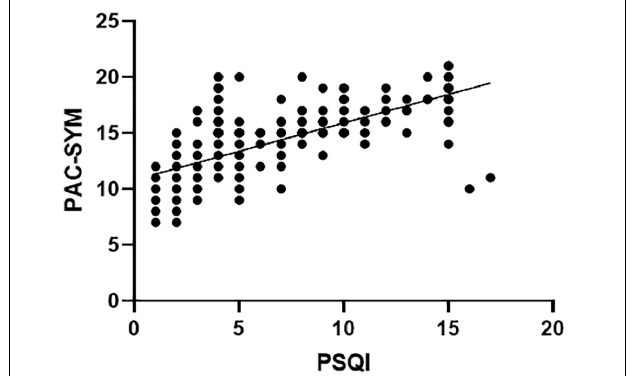
FIGURE 2 | Sleep quality scores (PSQI) significantly correlated with constipation symptom scores (PAC-SYM) in FC patients (Pearson Coefficient = 0.686, P <